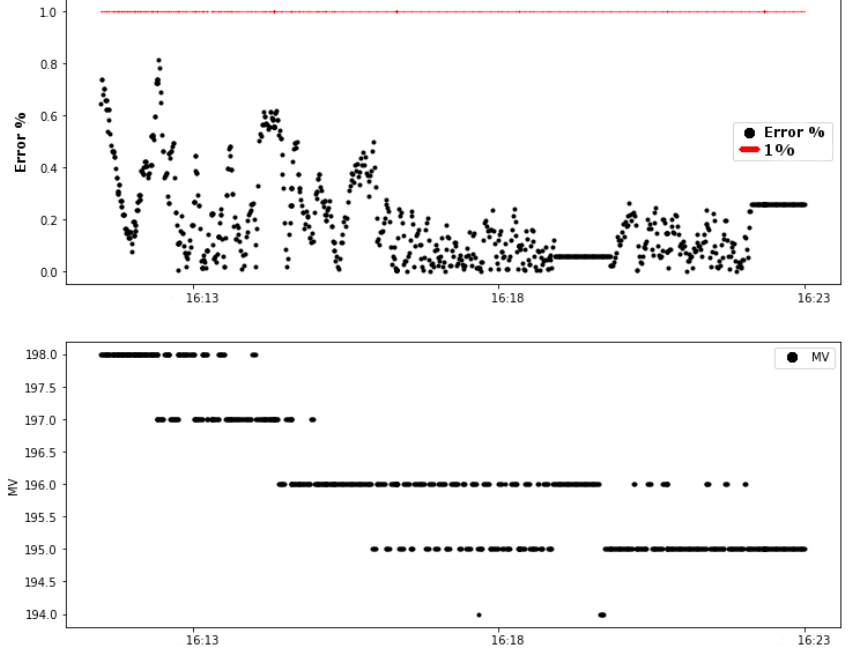
Figure 14. Result of the control system based on link stability: error (%) and